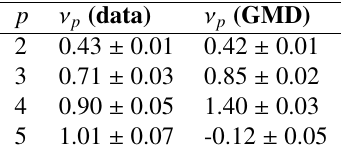
Table 1: Comparison of gradient parameters ν